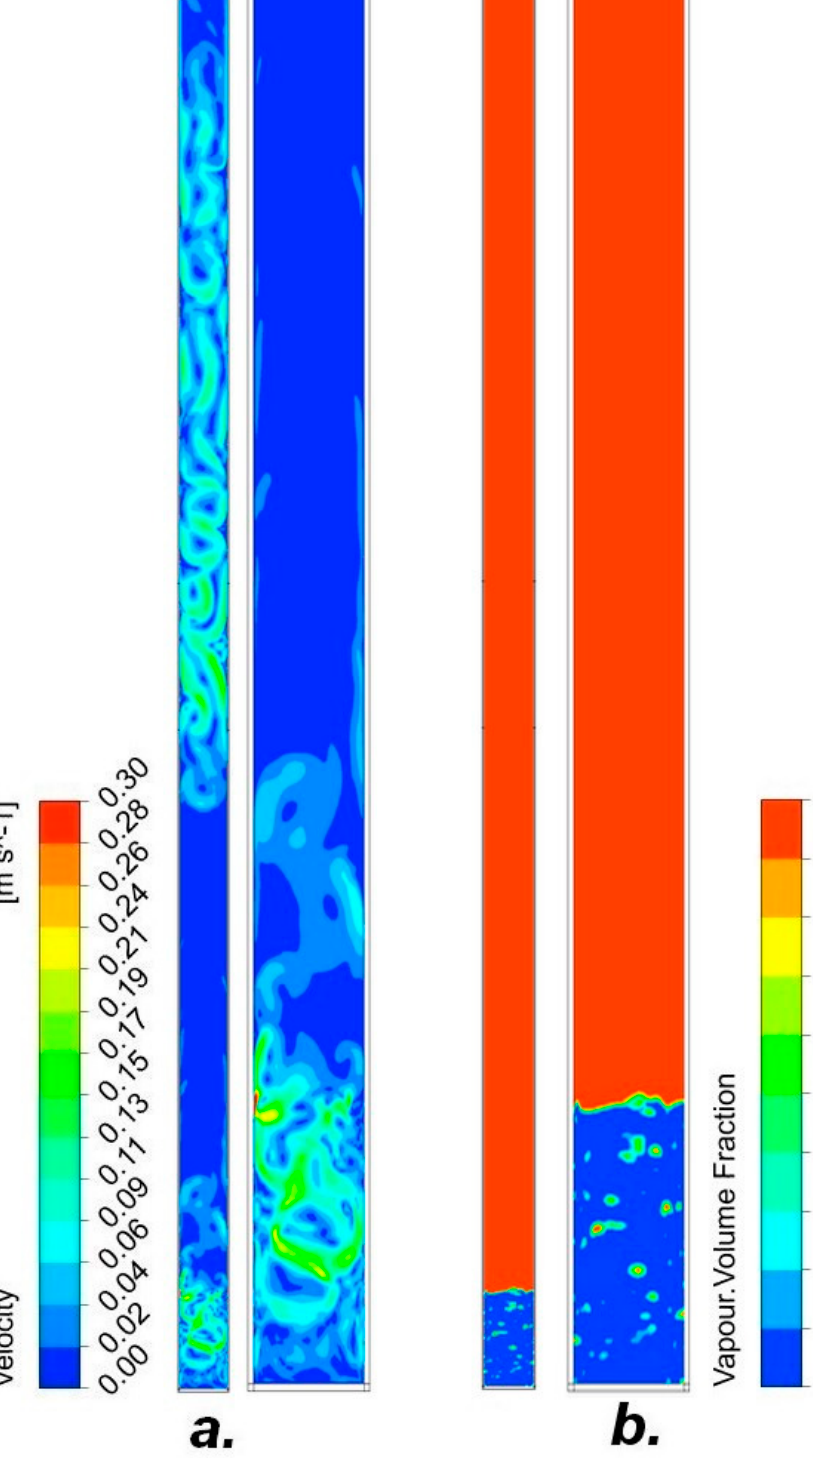
Figure 28. ( a ) Fluid velocity in the total heat pipe and in the condenser section, ( b ) the volume fraction of steam in the total heat pipe and in the evaporator section.